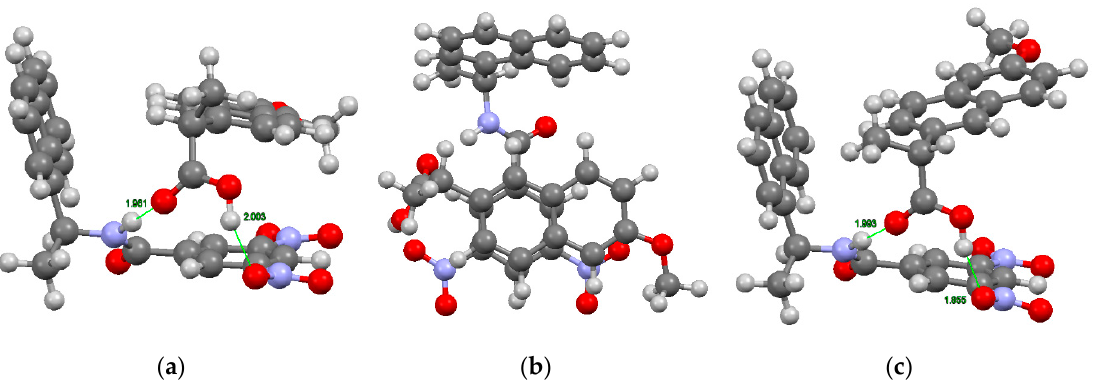
Figure 10. The lowest energy structures of ( S )- A ( a ), ( S )- A , top view ( b ) and ( R )- A ( c ). Selected bond lengths are indicated in Å. B3LYP/def2-TZVPP//M06-2X/def2-TZVPP (COSMO, ε = 2.78).